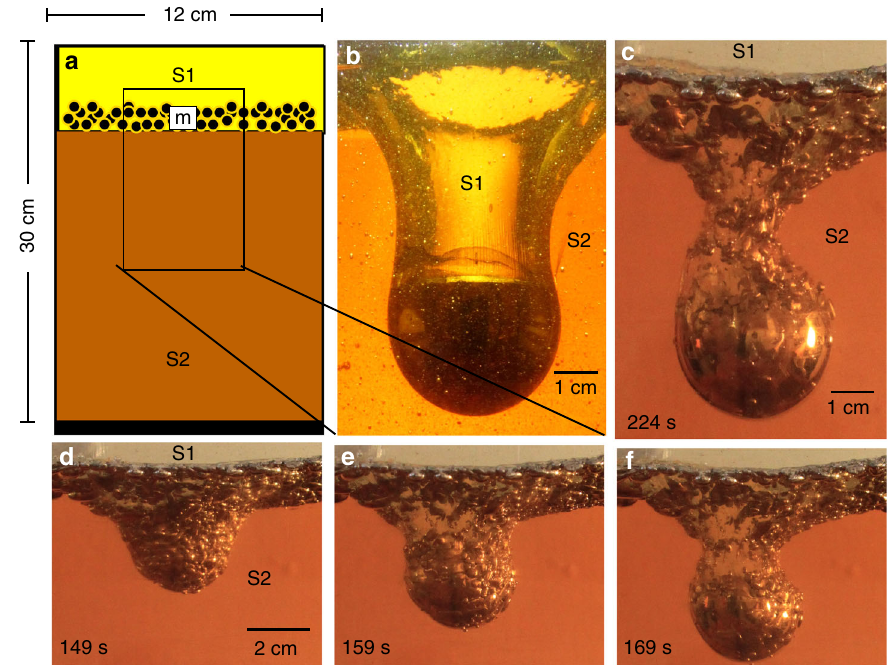
Fig. 1 Gravitational instability of an emulsi fi ed metal pond. a Schematic of the initial conditions for each experiment (described in Methods). The metal emulsi fi ed layer (m) rests at the S 1 − S 2 interface at t o . b Metal diapir and trailing conduit descending from a smooth metal pond. Photo image is cropped to the size of the small black box shown in a . All liquid metal collects quickly and descends in the fi rst large diapir. Conduit material travels down and returns back up through conduit. c Metal diapir and trailing conduit descending from an emulsi fi ed metal pond (Experiment 14 at 224 s). Metal droplets descend in two stages. Conduit material travels down through the conduit and also by entrainment around each droplet. Time sequence of photographs (taken from a side view camera in spotlight) at d 149 s, e 159 s, and f 169 s showing the gravitational instability of an emulsi fi ed metal pond and formation of an emulsi fi ed diapir (Experiment 14). A later photograph of this experiment is shown in c at 224